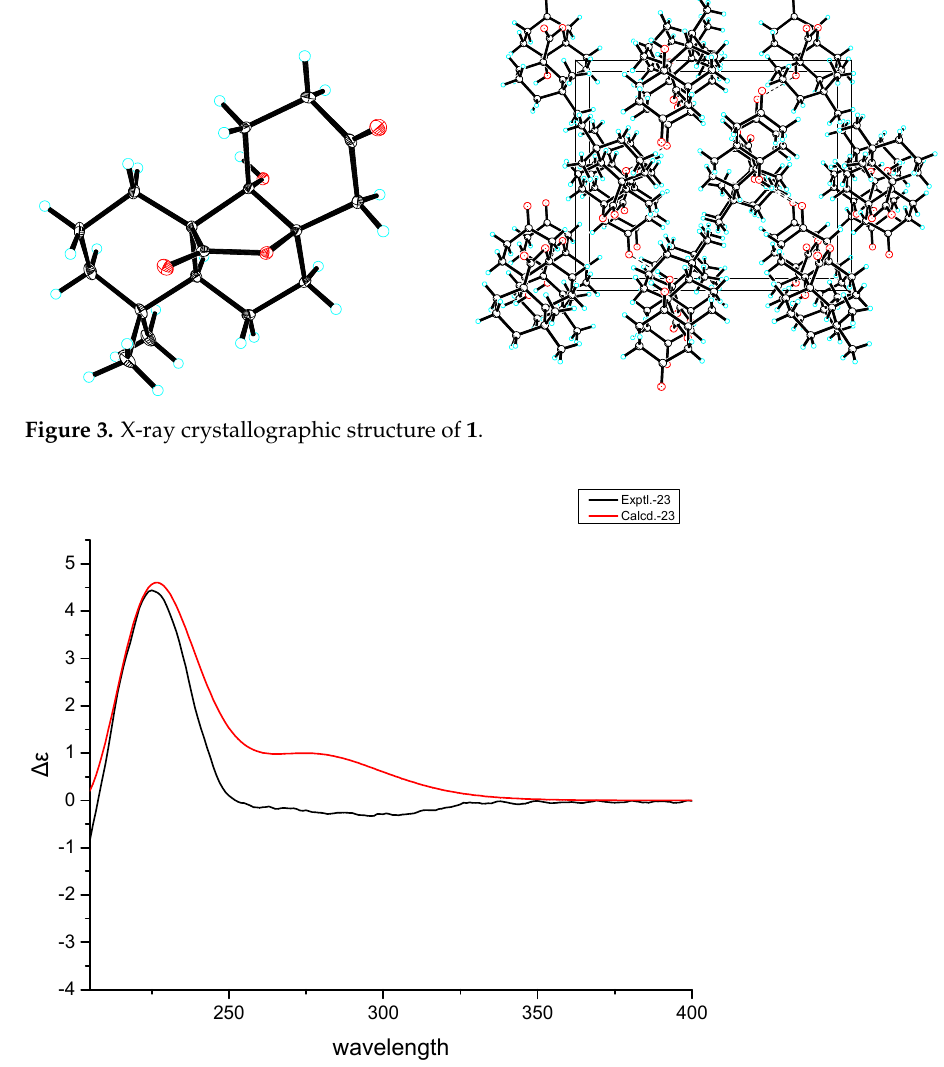
Figure 4. Experimental (black) and calculated ECD (red) spectra of 1 . Compound 2 was obtained as colorless cubic crystals (MeOH) with the molecular formula determined as C 17 H 24 O 4 through the analysis of its NMR and HRESIMS data [ m/z 315.1564 [M + Na] + (calculated as 315.1567)]. The IR spectrum of 2 displayed the absorptions of hydroxyl (3452 cm − 1 ), carbonyl (1693 cm − 1 ) and lactone (1719 cm − 1 ) groups. The similarity of the NMR spectroscopic data and the same molecular formula of 2 to 1 suggested that the two compounds possessed the same planar structure. The significant differences of the 13 C-NMR data at C-8 ( δ C 84.3), C-9 ( δ C 80.5) and C-11 ( δ C 24.4) indicated that 2 differs from 1 only by the stereochemistry at C-9, which was confirmed by the X-ray crystallographic analysis of a crystal obtained from the crystallization of 2 in MeOH (Figure